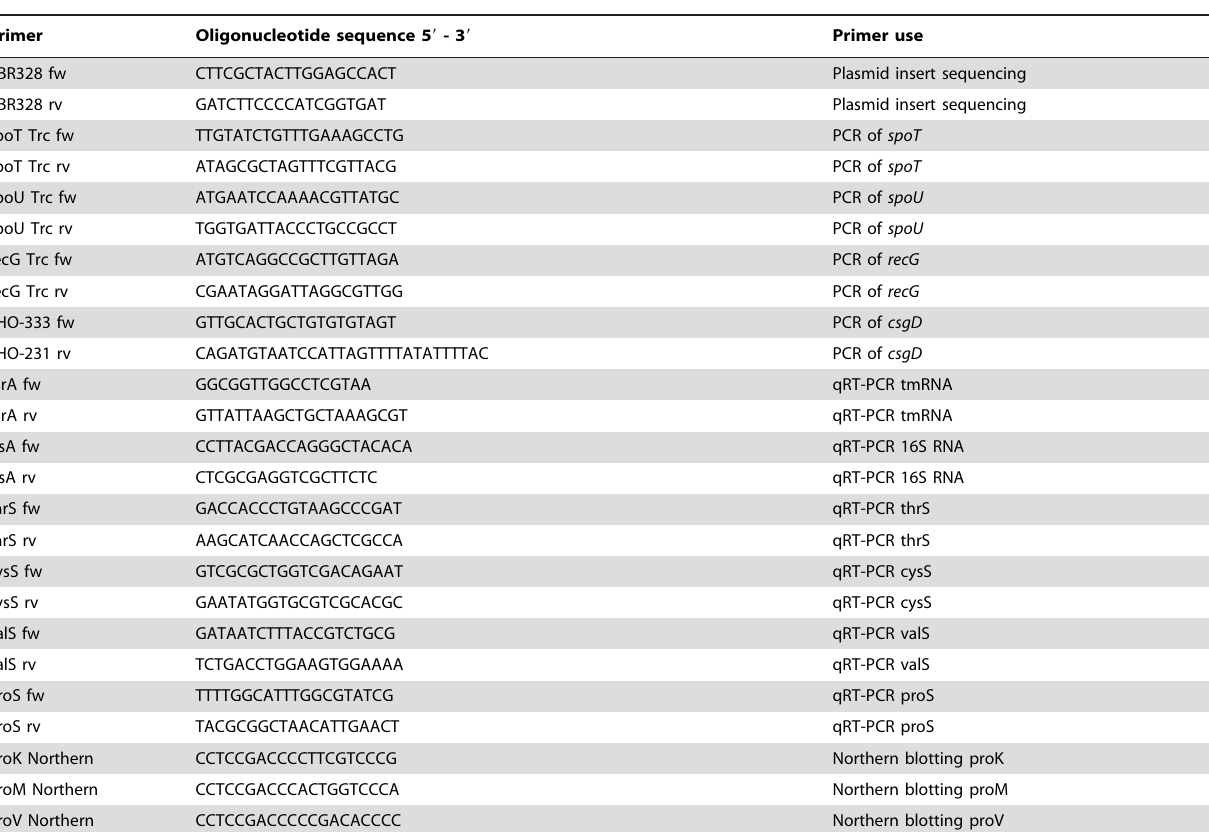
Table 5. Oligodeoxyribonucleotide